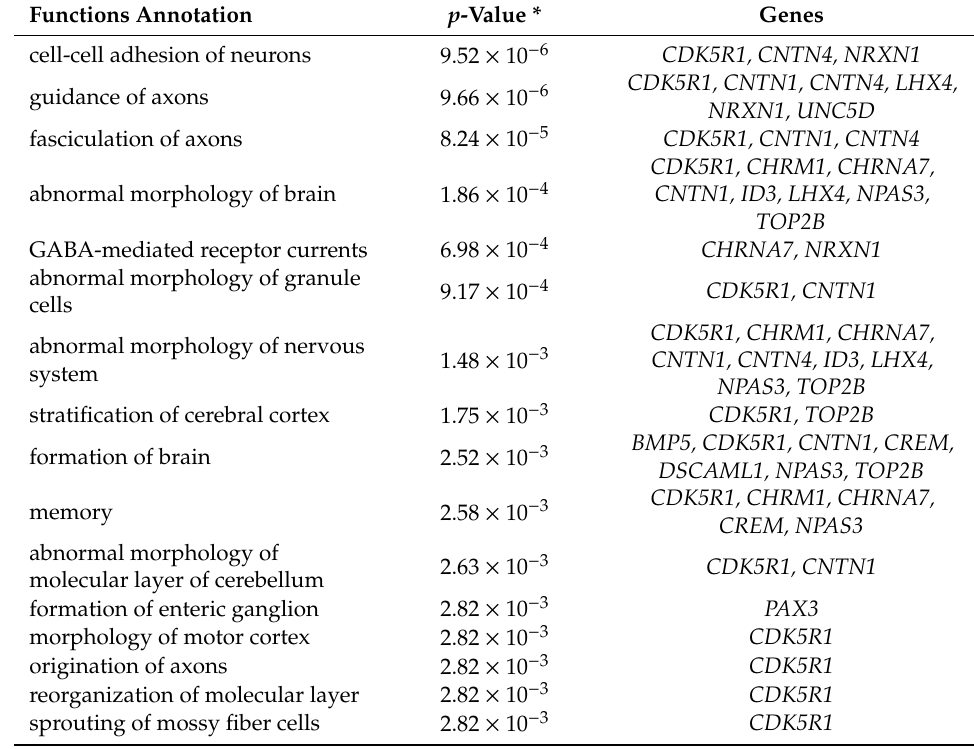
Table 4. Neurological functions associated with genes implicated by language